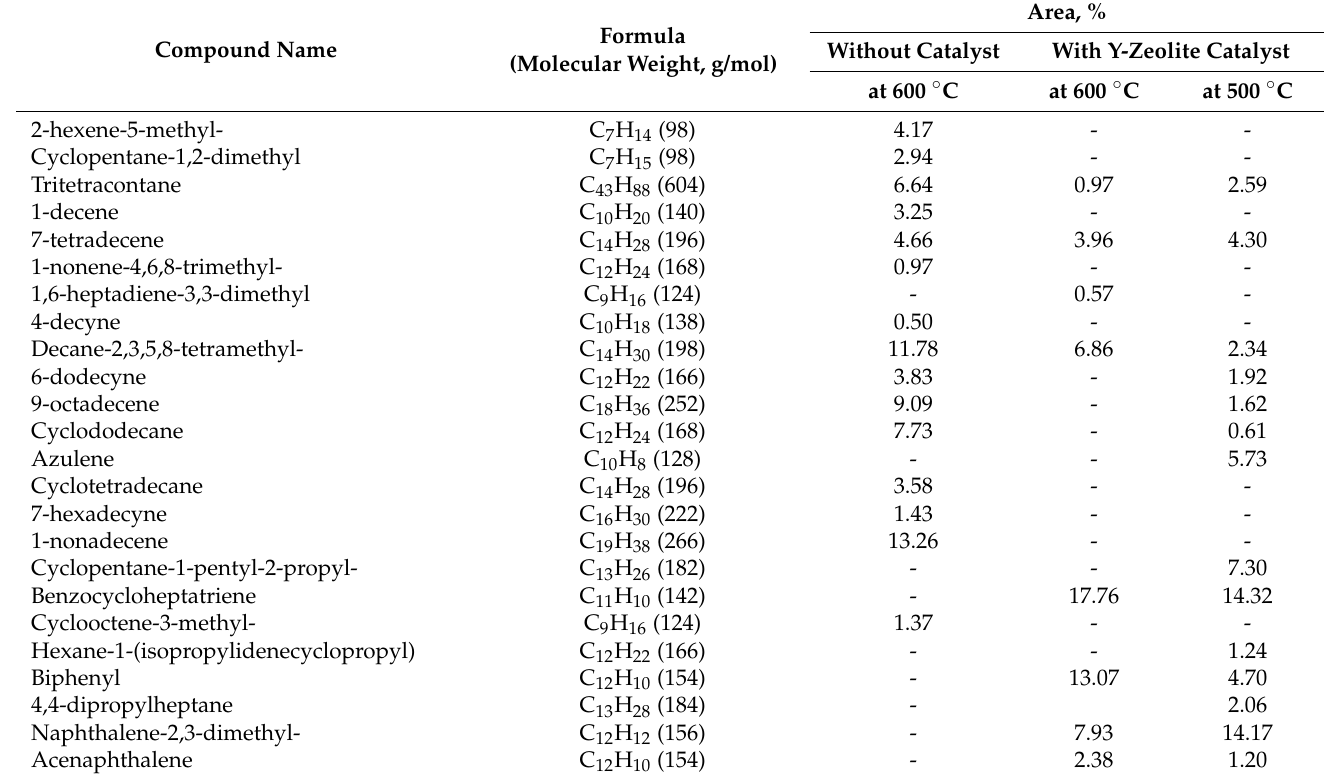
Table 3. Analysis of industrial plastic waste 1 by Py-GC/MS with and without Y-zeolite